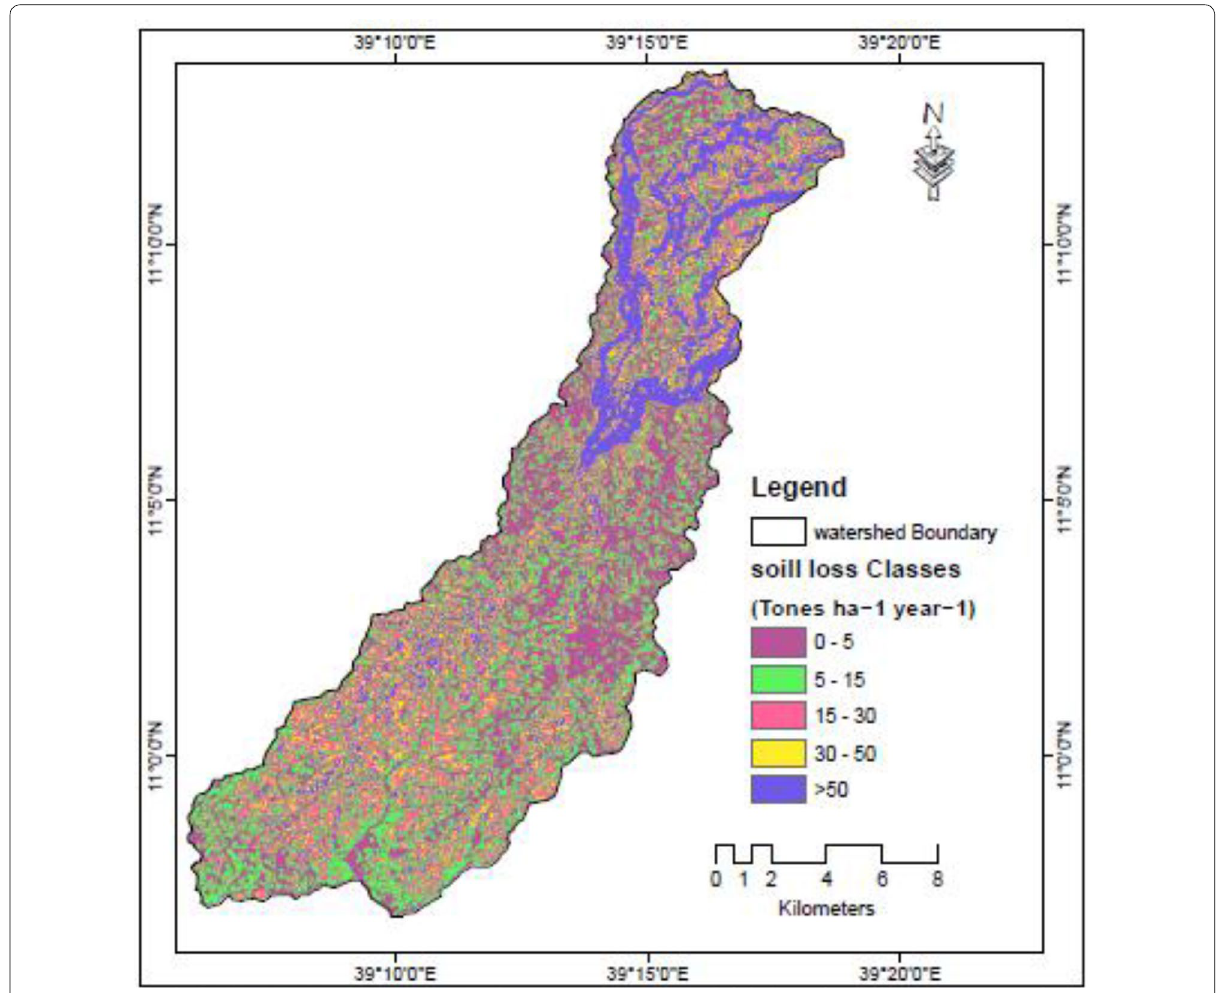
Fig. 11 Map depicting spatial variation of soil erosion loss in Gedalas